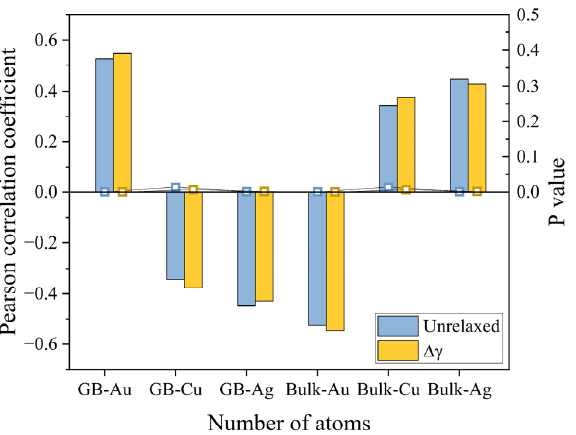
Figure 7. The correlation between the number of different atoms in different regions and the unrelaxed GB energy and the energy decrease during relaxation ( ∆γ ).